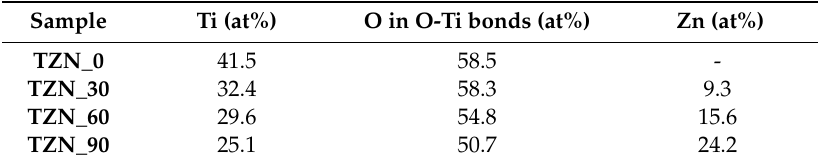
Table 2. Surface atomic concentrations of the main elements in the sputtered samples. Sample